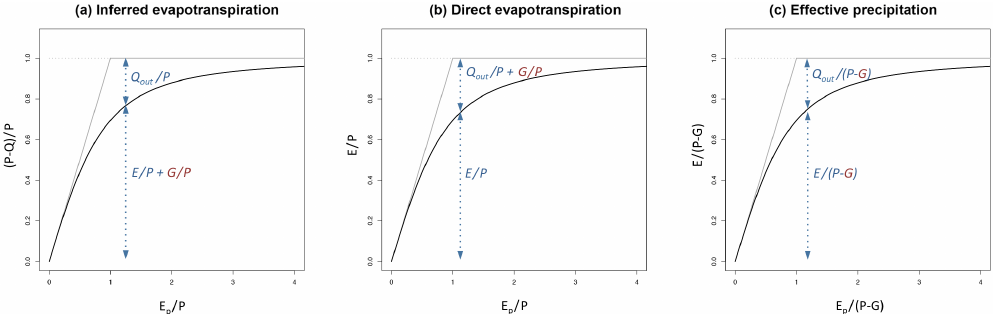
Figure 6. Illustration of the treatment of groundwater contributions for each of the three approaches. The black lines show the water and energy limits and an example Budyko curve, similar to Fig. 4. Arrows indicate the water balance component represented above and below the curve in each